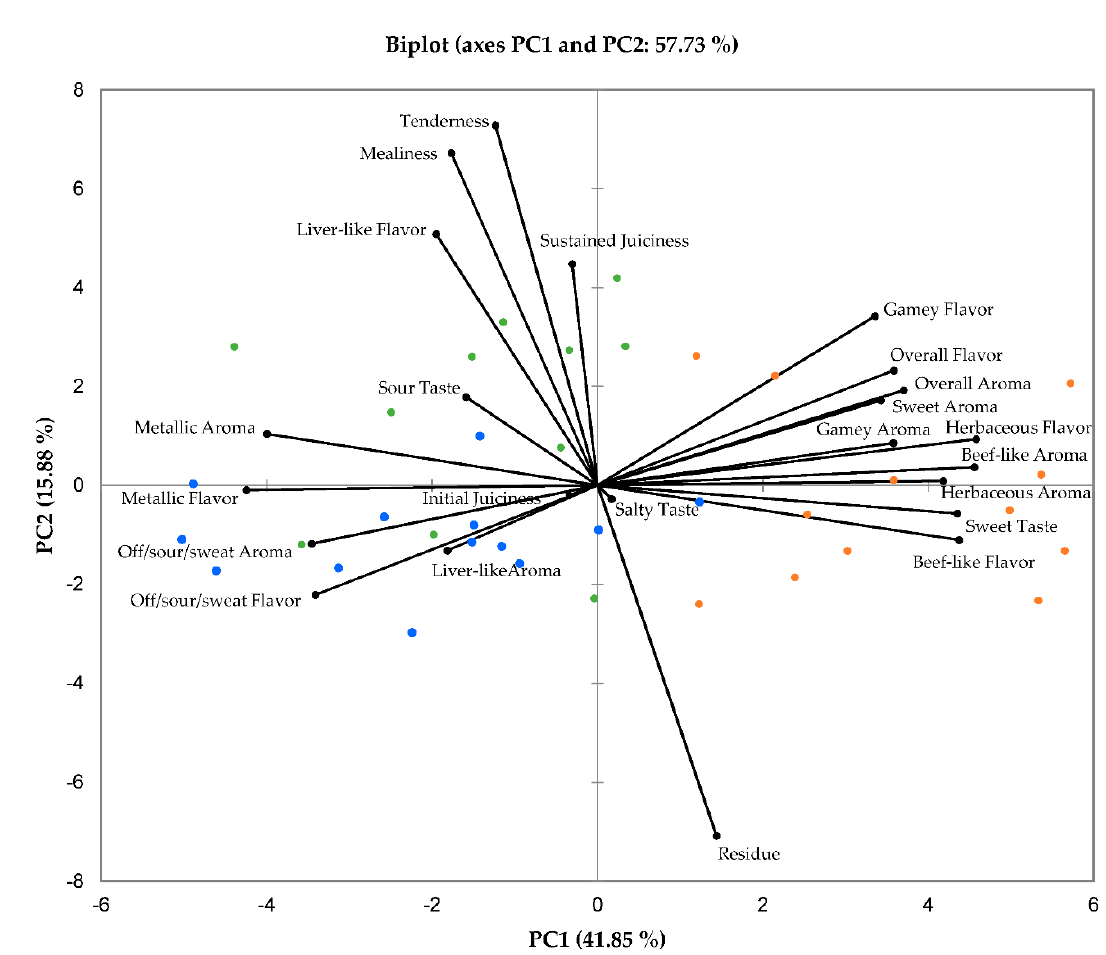
Figure 1. Principal component analysis (PCA) biplot depicting the means of the sensory attributes of sub-adult male impala longissimus thoracis et lumborum meat. A total mixed ration was fed in the intensive system ( n = 12), while supplementation (with the same ration) was provided on Savanna vegetation ( n = 12), and no supplementation was provided to the extensive system on Renosterveld vegetation ( n = 12). The intensive system impala meat samples are represented blue, the semi-extensive system impala meat samples in green and the extensive system impala meat samples in orange.